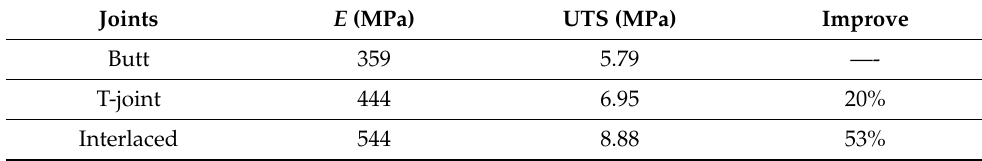
Table 2. Tensile test data for different joint